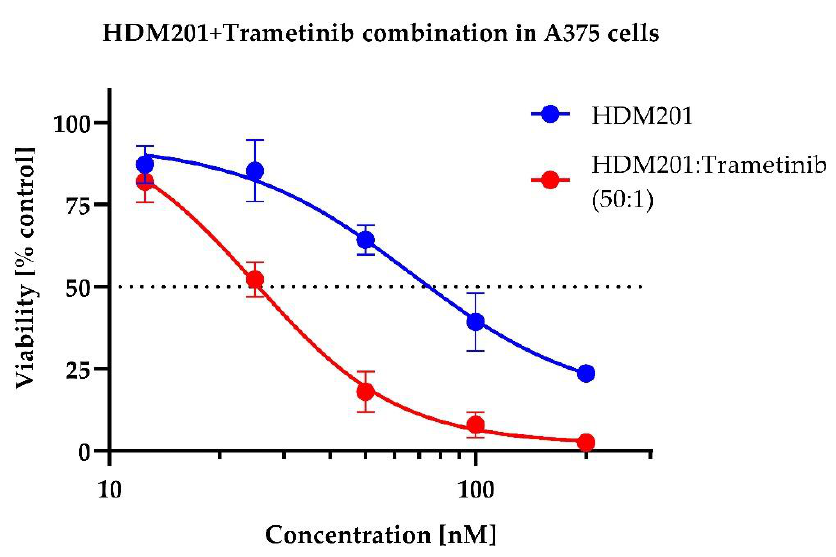
Figure 3. Curve shift for HDM201 combination with Trametinib. MTS assay, mean from n = Figure 3 . Curve shift for HDM201 combination with Trametinib. MTS assay, mean from n = 4.